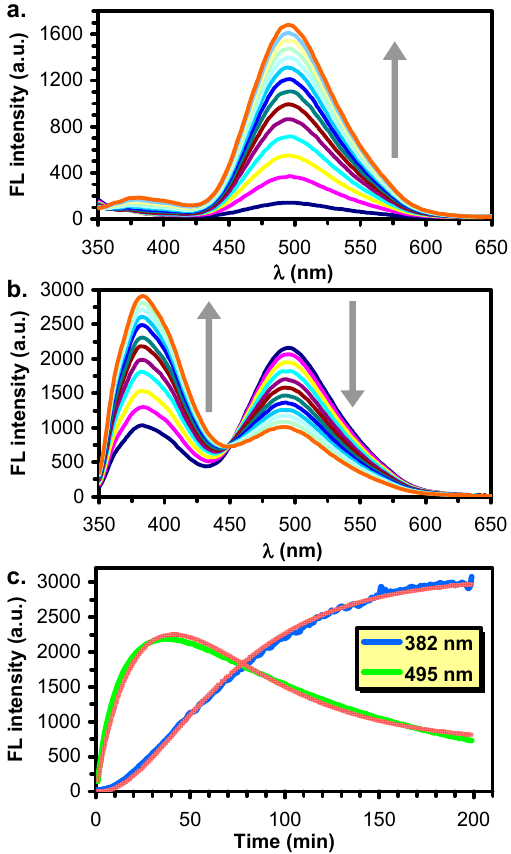
Figure 7. The evolutions of the emission spectra during the reaction of 1,5-DIN with the mixture of THF / water and HgCl 2 in the time interval 0–27 min ( a ) and 90–210 min ( b ). The variations of the fluorescence intensities at λ = 382 nm and 495 nm recorded at 60 s intervals. The blue and the green solid lines represent the measured fluorescence intensities at λ = 382 nm and 495 nm, respectively, and the red solid lines are the fitted curves using Equations (8) and (9) ( c ). Experimental conditions: [H 2 O] = 27.8 mol/L (~50% (V/V)), [1,5-DIN] = 2.5 × 10 − 6 mol/L, [HgCl 2 ] = 1.2 × 10 − 3 mol/L and T = 25 °C.